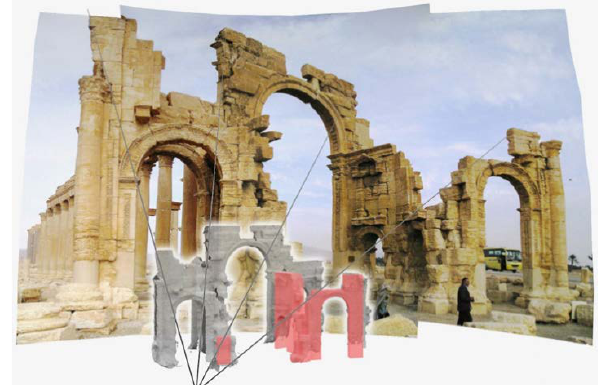
Figure 8. The destroyed Arch of Triumph in Palmyra, a projection of a panorama and the reconstructed model. Shown in grey is the part from dense multi-view 3d reconstruction and in red is the part from panoramic image-based modelling.